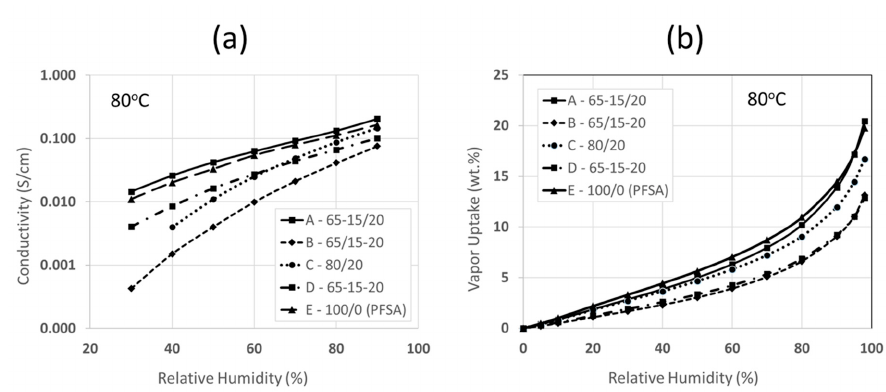
Figure 6. ( a ) In-plane proton conductivity at 80 °C versus relative humidity for the five membranes listed in Table 4 (Type-A through Type-E); ( b ) Gravimetric equilibrium water vapor sorption isotherms at 80 °C for the same five membranes.